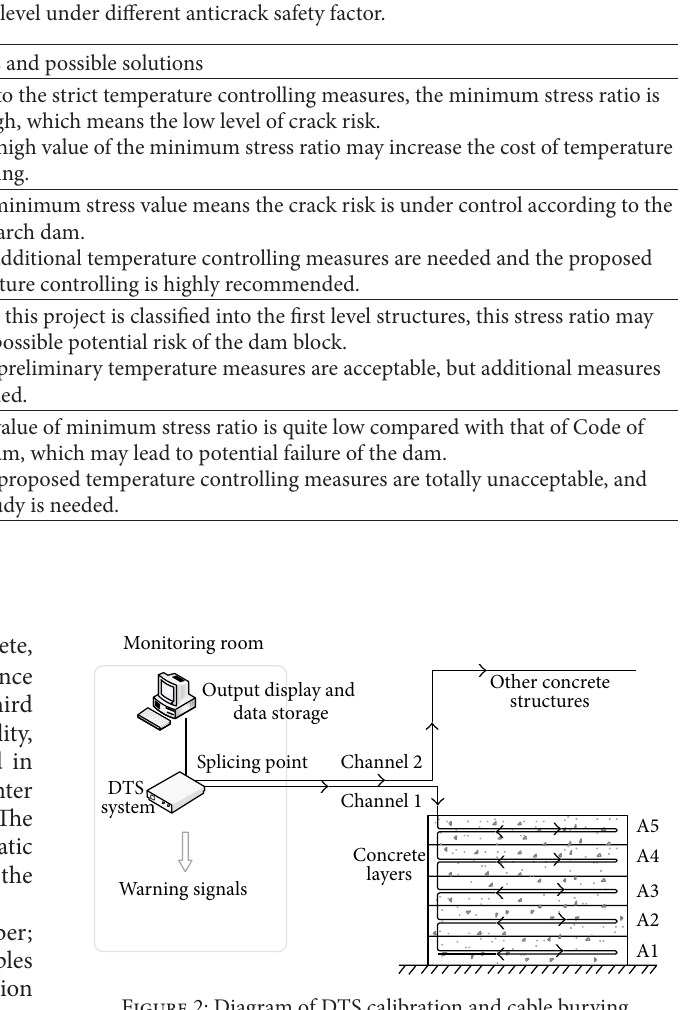
Figure 2: Diagram of DTS calibration and cable